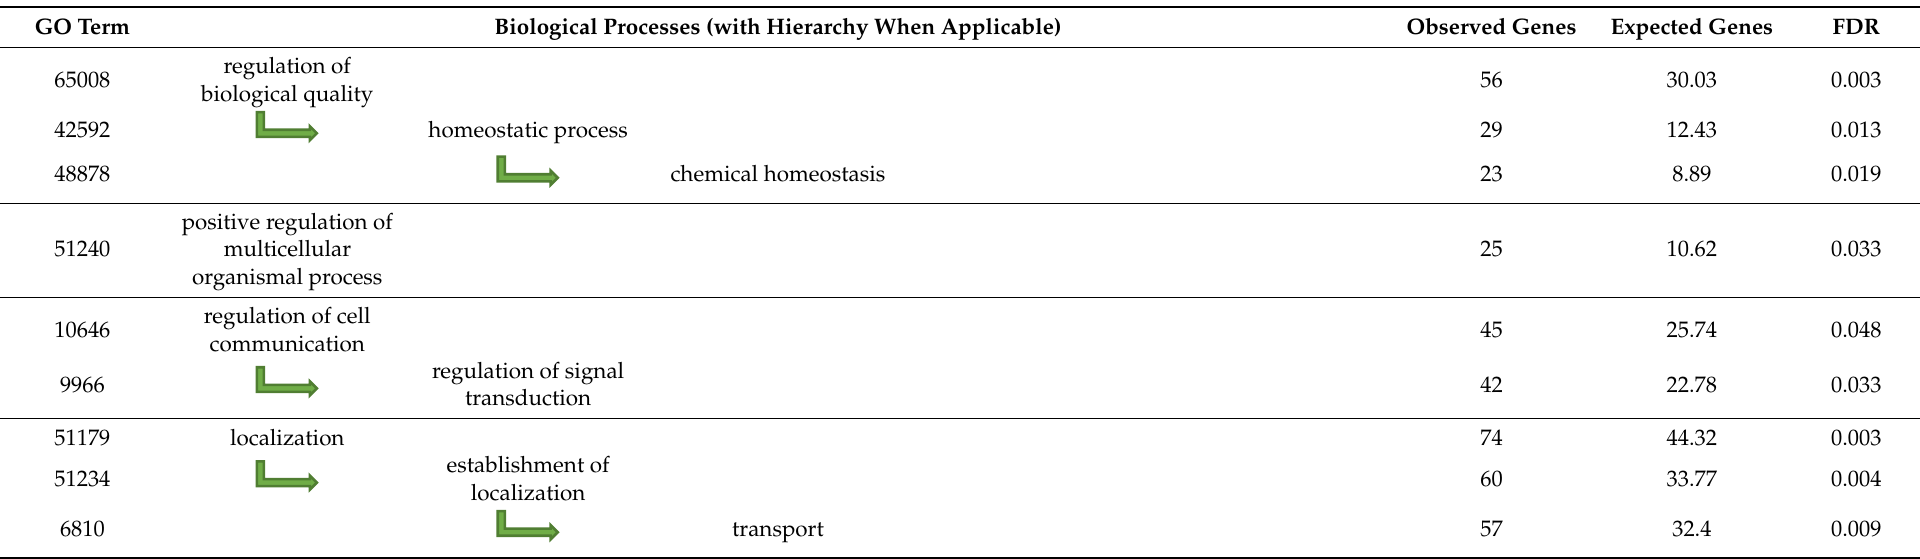
Table 5. Gene Ontology analysis for genes associated with total number born, number born alive, number of stillborn, litter birth weight, and corpus luteum number in pigs.